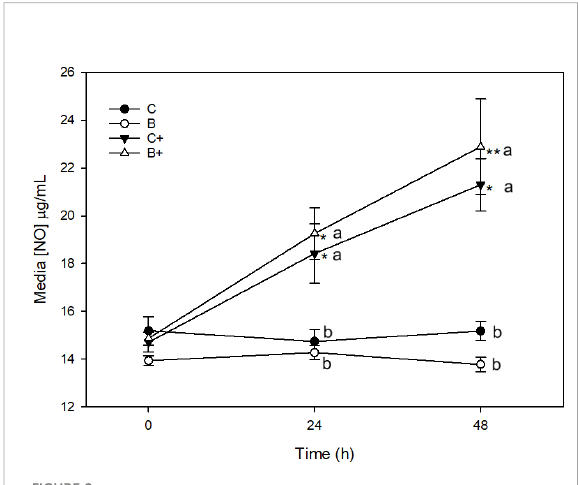
FIGURE 2 Media [NO] (µg/mL) from explants cultured in basal media (C) or media conditioned with 1% DD20; Ethanol (0.3%) (B) in the presence (+) or absence of lipopolysaccharide (10µg/mL). *denotes signi fi cant change from baseline within treatments. Letters denote signi fi cant difference between treatments at individual time